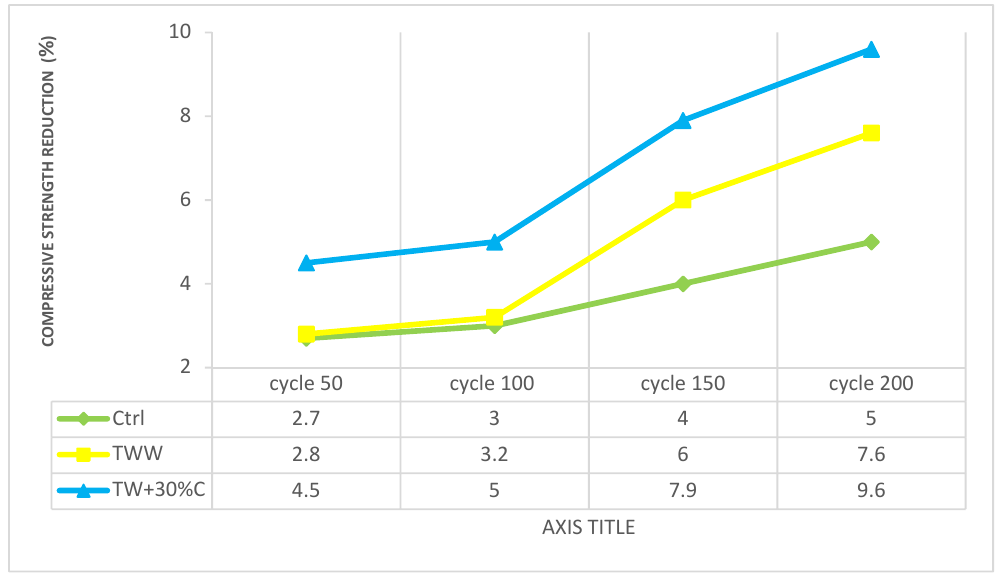
Figure 10. The compressive strength reduction in each rapid freezing and thawing cycle.